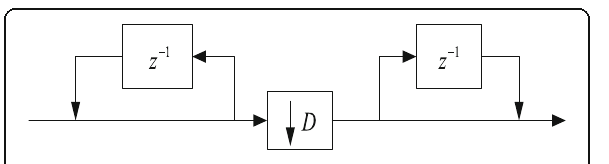
Fig. 4 CIC implementation structure Fig. 5 CIC amplitude frequency